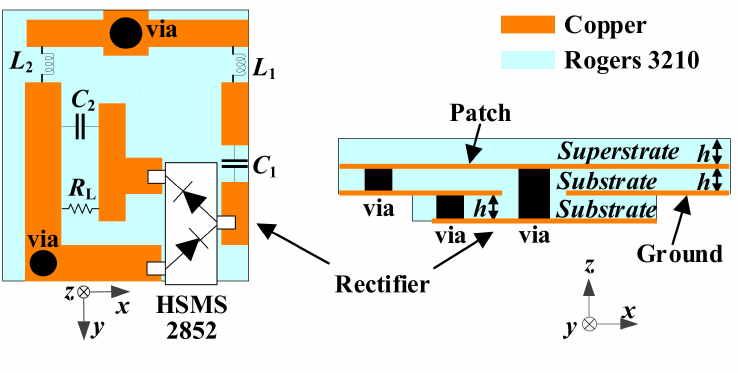
Figure 14. Configuration for integrating the rectifier circuit as a